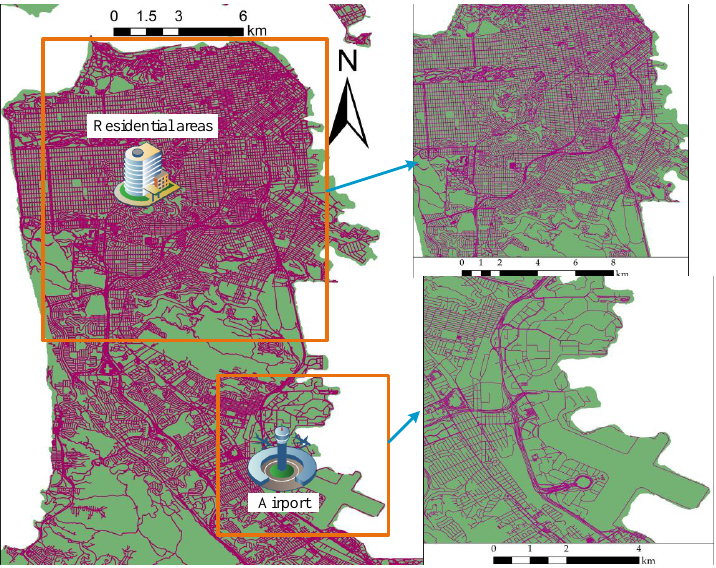
Figure 7. Road network information. The results of trajectory visualization on datasets T-1, T-2, T-3, and T-4 are shown in Figure 8a – d, respectively.